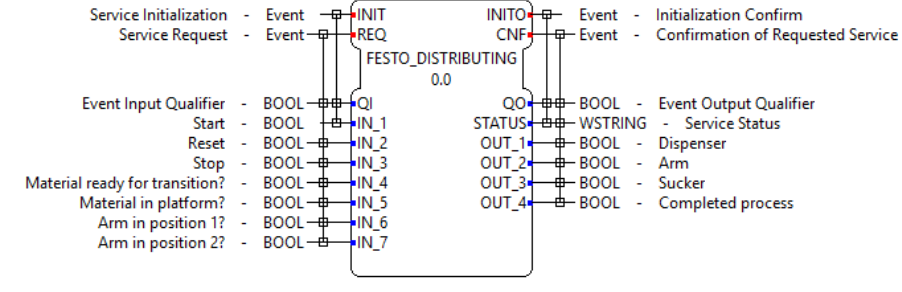
Figure 10. Festo_distributing FB.